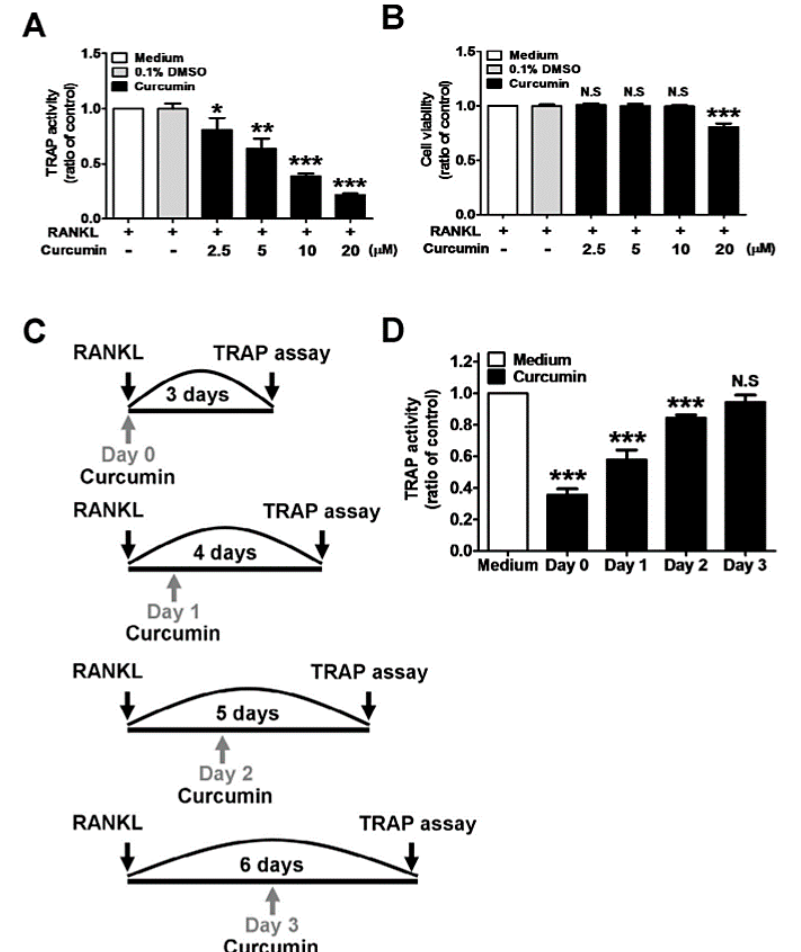
Figure 4. Curcumin inhibits the RANKL-induced osteoclastogenesis of RAW264.7 cells at an early stage. RAW264.7 cells (1 × 105 per well in a 24-well plate) were treated with an indicated concentration of curcumin in the presence and absence of 100 ng/mL RANKL. ( A ) Cells were lysed and reacted with buffer containing tartrate and p-nitrophenylphosphate (pNPP) solution. TRAP activity was analyzed using a spectrophotometer. ( B ) RAW264.7 cells were treated with curcumin in the presence and absence of RANKL. Cytotoxicity was determined using MTT assay. ( C , D ) RAW264.7 cells were treated with RANKL, and curcumin (10 M) was added at different time points (Days 0–3 after RANKL stimulation). TRAP activity was detected after adding curcumin following three days of culture. Data represent the mean ± SD of at least five independent experiments. * p < 0.05, ** p < 0.01, *** p < 0.001 (Student’s t-test), different from values after treatment with RANKL alone. Adopted with permission from Mau et al. with license number 4595960699160 [71].